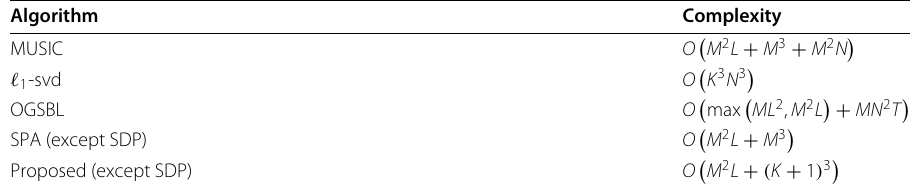
Table 2 The computational complexity of the five DOA estimation algorithms Algorithm Complexity